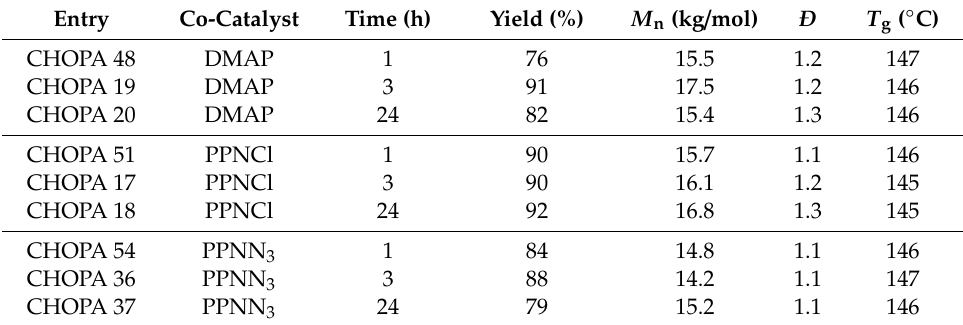
Table 2. CHO / PA copolymerization catalyzed by complex 1 and di ff erent co-catalysts a .